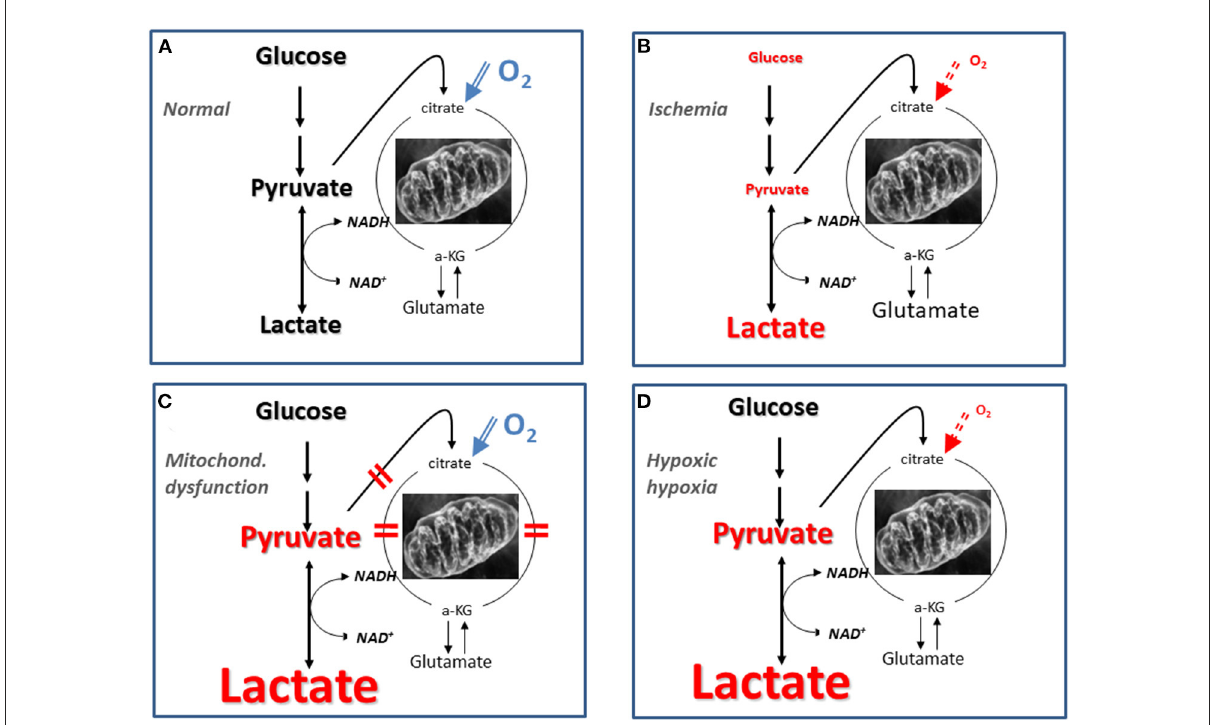
FIGURE4 Schematic illustration of biochemical patterns obtained utilizing intracerebral microdialysis under normal conditions (A) , during cerebral ischemia (B) , mitochondrial dysfunction (C) , and hypoxic hypoxia (D) . Mitochondrial dysfunction may be caused by lesions at various steps in the citric acid cycle as indicated by the red bars in (C) . The font size reflects the level of the various variables in three conditions compared to their normal reference concentrations.